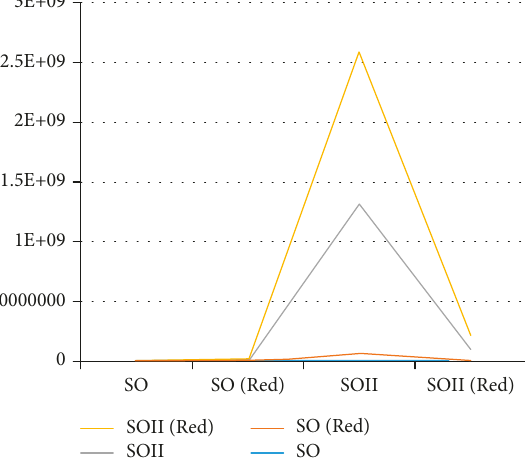
Figure 13: Graphical comparison of SO , SO